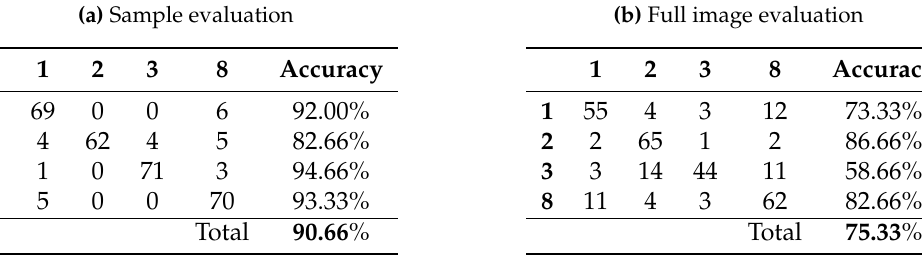
Table 1. Confusion matrix for the four poses selected using the NUS-II-B. ( a ) For the confusion matrix for the per window evaluation in the NUS-II-B, the accuracy is 90.66%; ( b ) results for the full image evaluation over the NUS-II-B. The accuracy is